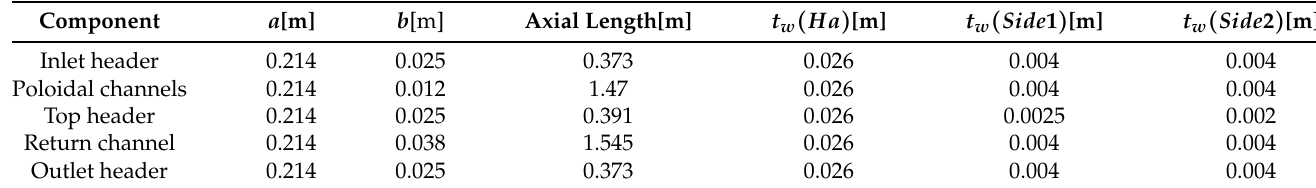
Table 8. Main geometrical parameters of LLCB flow path [51].